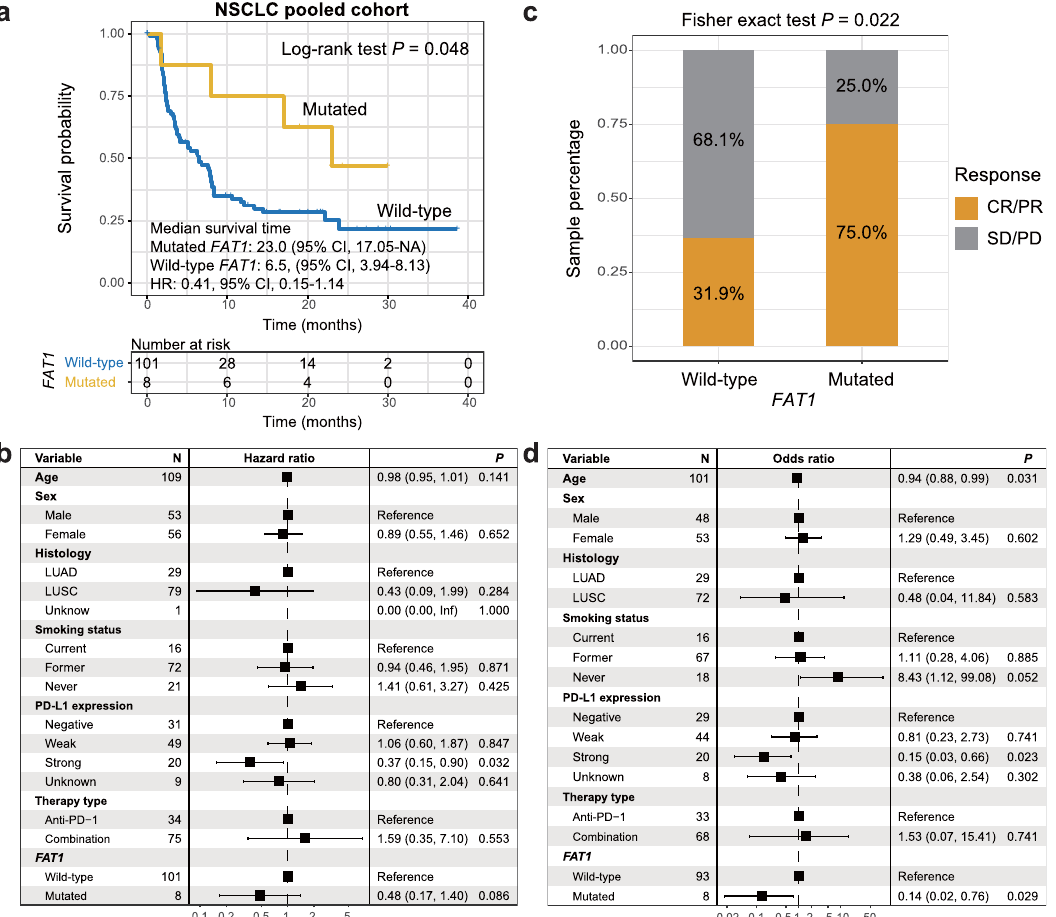
Fig. 4 Association of FAT1 mutations with ICI prognosis and response in NSCLC cohort. a Kaplan – Meier survival curves strati fi ed by FAT1 mutational status. b Multivariate Cox regression model between FAT1 mutations and ICI outcome with age, sex, histology subtype, smoking status, PD-L1 expression, and therapy type taken into account. Black box: hazard ratio; black scale bar, 95% con fi dence interval of hazard ratio. c Distinct ICI response rates in FAT1 mutated and wild-type subgroups. d Multivariate logistic regression model between FAT1 mutations and ICI response with age, sex, histology subtype, smoking status, PD-L1 expression, and therapy type taken into